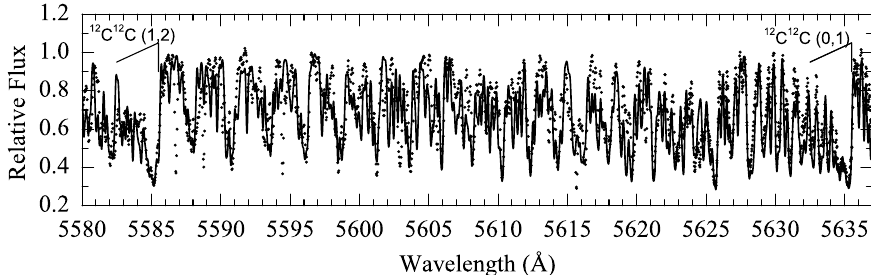
Fig. 8. The observed spectrum of HD 209621 in the wavelength range dominated by the C 2 Swan system (0,1) and (1,2) lines. The synthetic C 2 spectrum is given for the carbon abundance log ϵ (C) = 7.85.